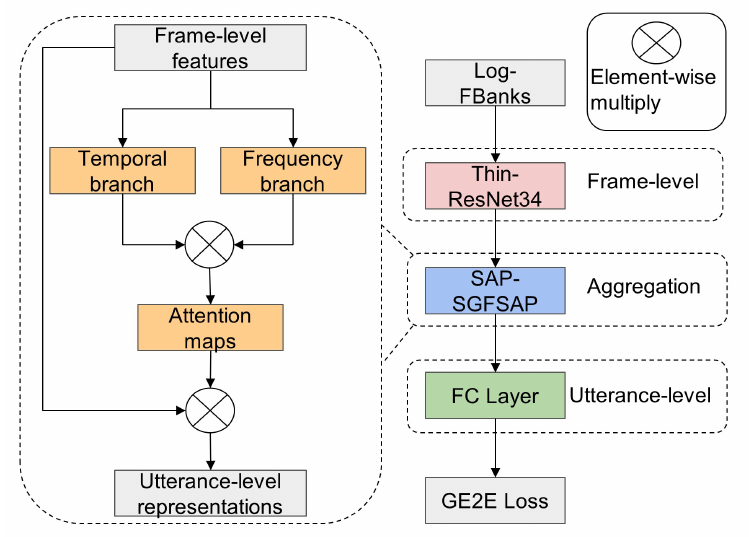
Figure 2. The CNN-based SV system using